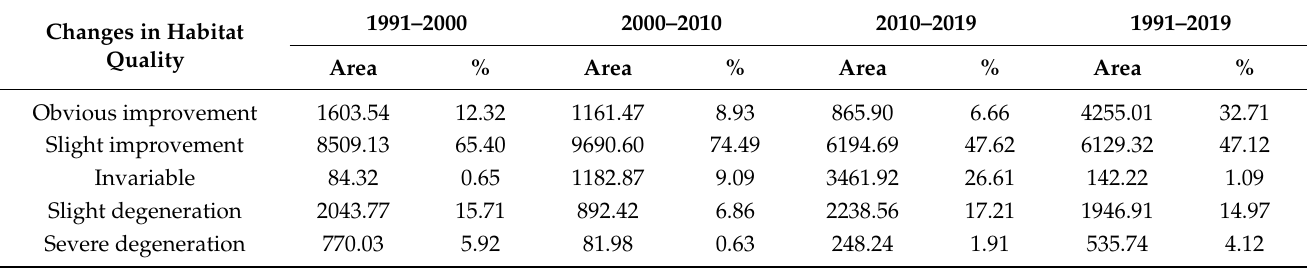
Table 7. Area and proportion of habitat quality grades along the Yellow River section of the Hobq Desert in 1991 – 2019.